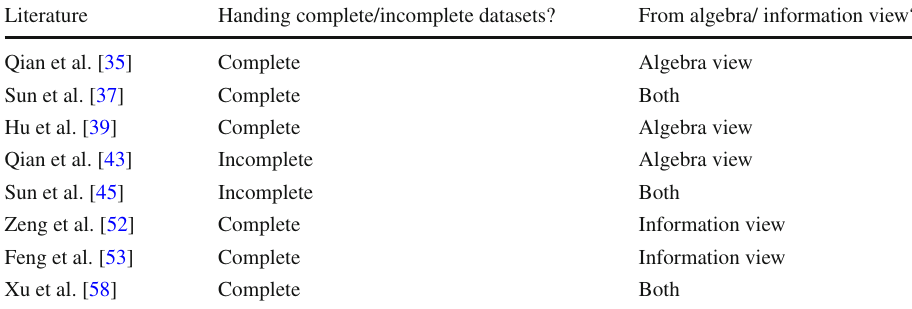
Table 1 Summary of some Literature Handing complete/incomplete datasets? From algebra/ information feature selection methods